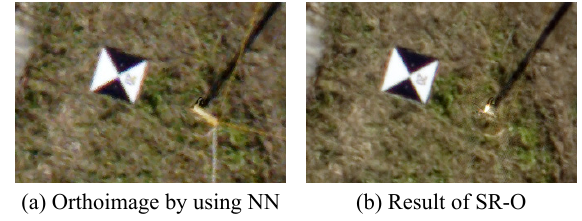
Figure 12. Orthoimage by using NN and result of SR-O